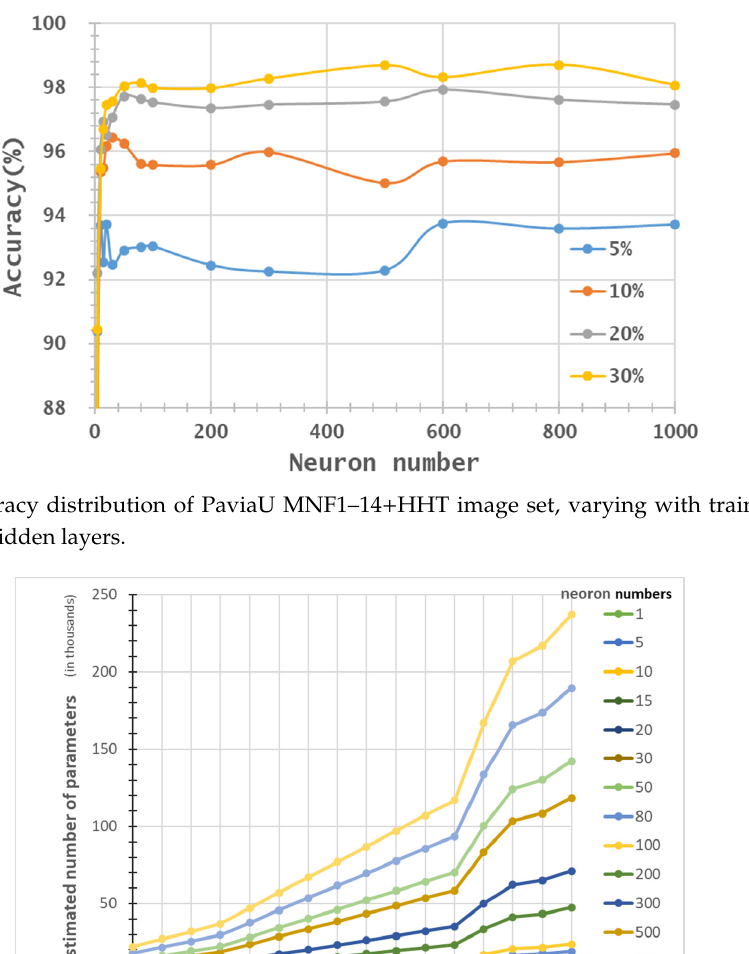
Figure 9. Accuracy distribution of PaviaU MNF1–10+HHT image set, varying with training sample proportion and hidden layers.